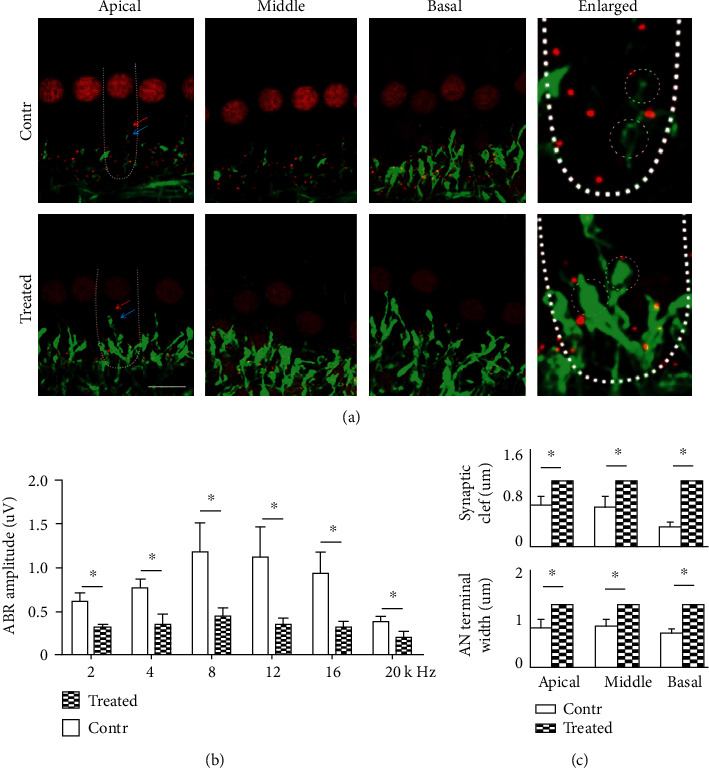
SS exposure causes swelling of fiber endings of postsynaptic ANs and amplitude changes in ABR wave I. (a) AN fibers were identified using anti-NF200 (green), and cochlear ribbon synapses were identified using anti-CtBP2 (red, blow inner HCs). Massively swollen AN fiber ends with reduced numbers of CtBP2-expressing puncta were evident in the SS group (compared to control group), as shown by white dashed lines (apical turns, left panel) and in enlargements (white circles, right panel). Bar = 10 μm. (b). ABR wave I amplitudes at 2, 4, 8, 12, 16, and 20 kHz. Amplitudes of ABR wave I were found reduced across all the frequencies above (p > 0.05); there were significant differences across frequencies (p < 0.05); n = 8 in the treated group and n = 6 in the control group. (c) Cochlear ribbon synapse morphological properties. Synaptic clef was enlarged after SS treatment; there were significant differences in apical, middle, and basal turns (p < 0.05, top). Swelling at the AN terminals was found after SS treatment; there were significant differences in apical, middle, and basal turns (p < 0.05, bottom).